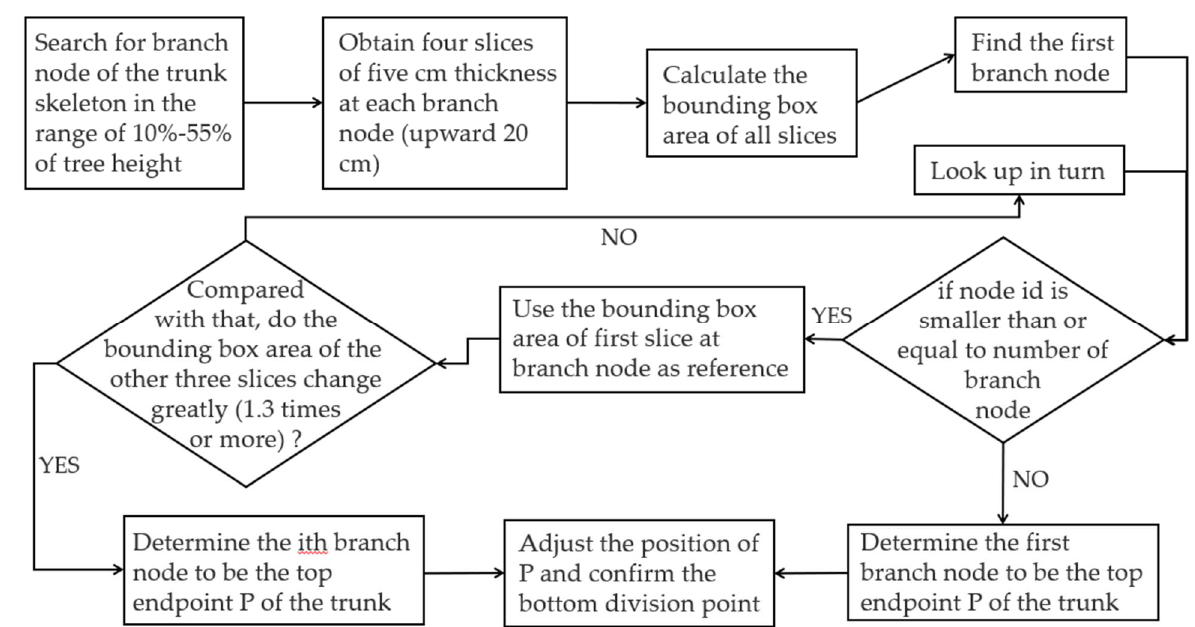
Figure 6. The algorithm process of finding the top endpoint P of the